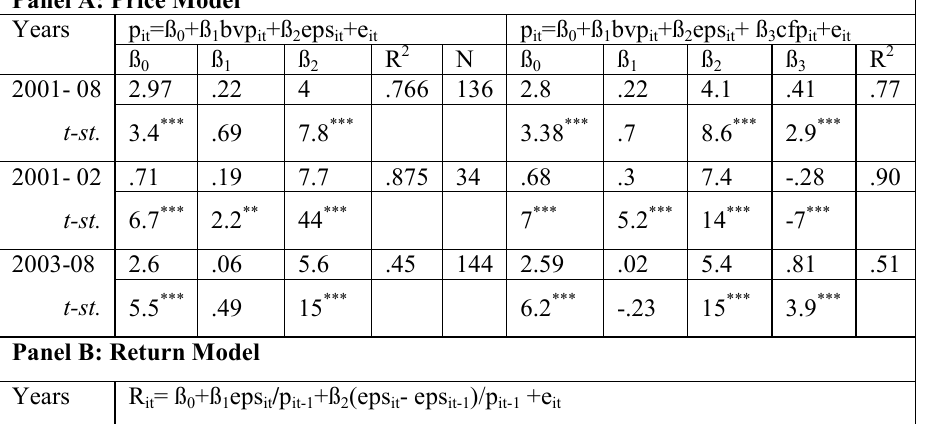
Table 2 Result of Regression-Variations Approach Panel A: Price